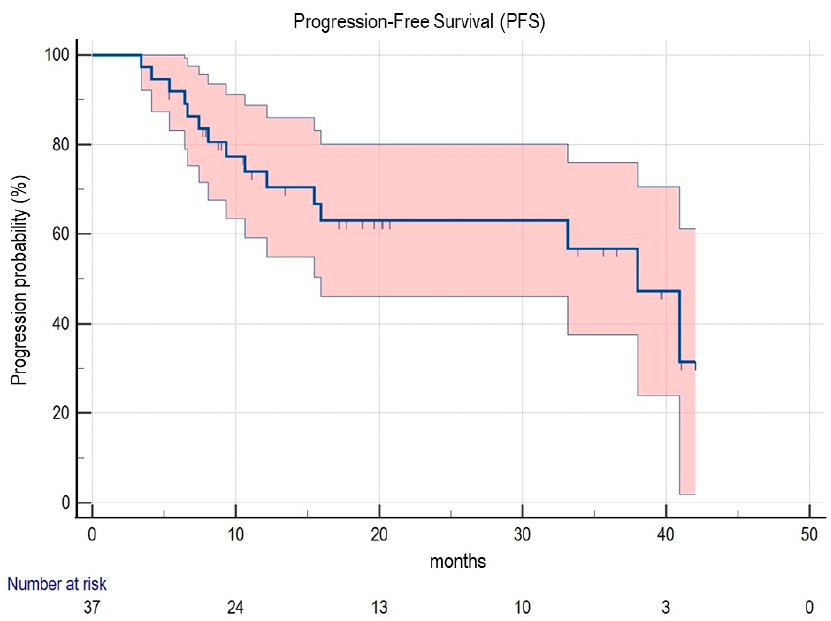
Figure 1. Kaplan-Meier curve for PFS in the whole sample. Abbreviations: PFS, progression-free survival.